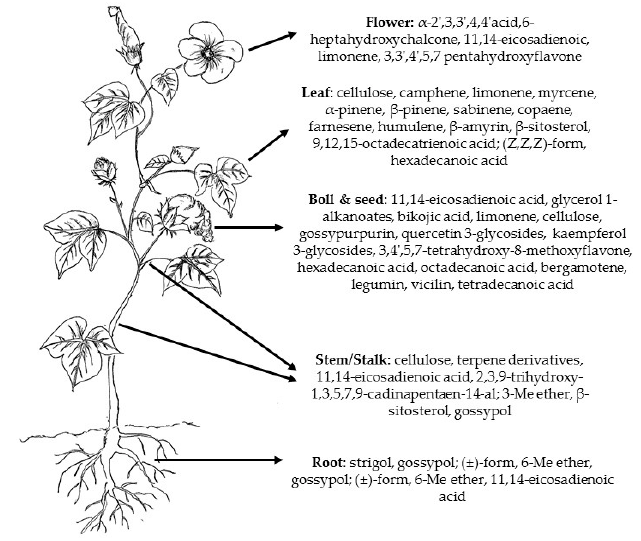
Figure 2. Distribution of common secondary metabolites in cotton plant.